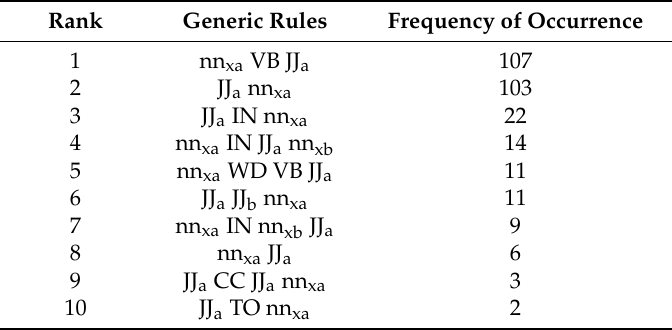
Table 6. Generic rules with their corresponding